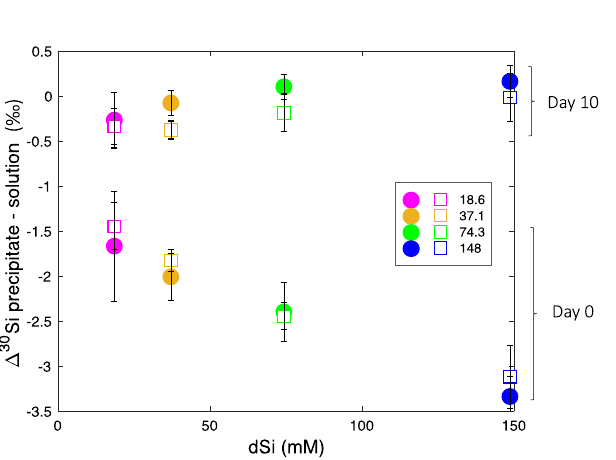
Table 1. Results of the curve fitting of the Si isotopic fractionation during precipitation ( (cid:31) 30 Si p-s ) over time for the abiotic and the biomimetic (R5) experiment.